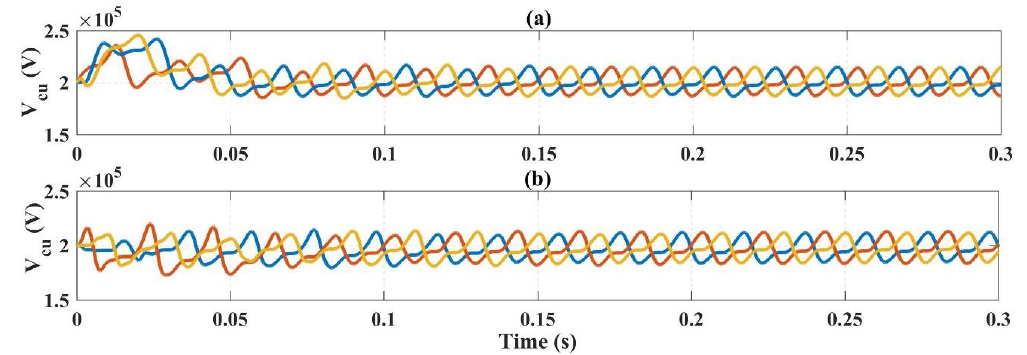
Figure 13 . Arm capacitor voltage; ( a ) control with SMC; ( b ) control with PR . Figure 13. Arm capacitor voltage; ( a ) control with SMC; ( b ) control with PR.